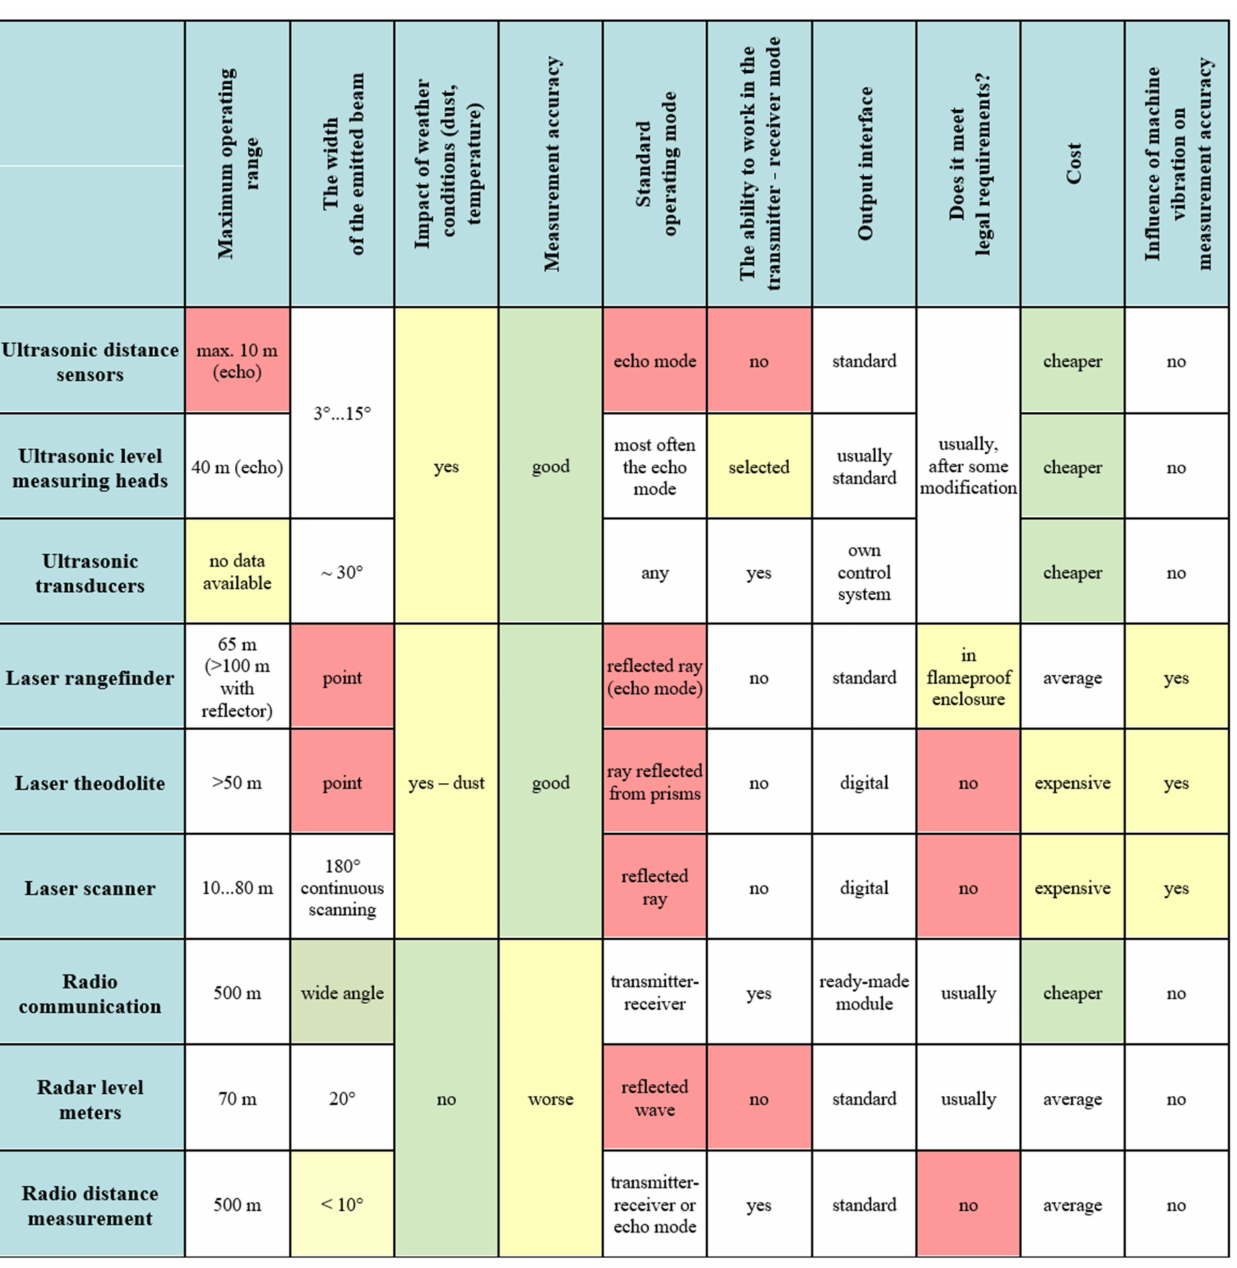
Figure 6. SWOT evaluation of measuring